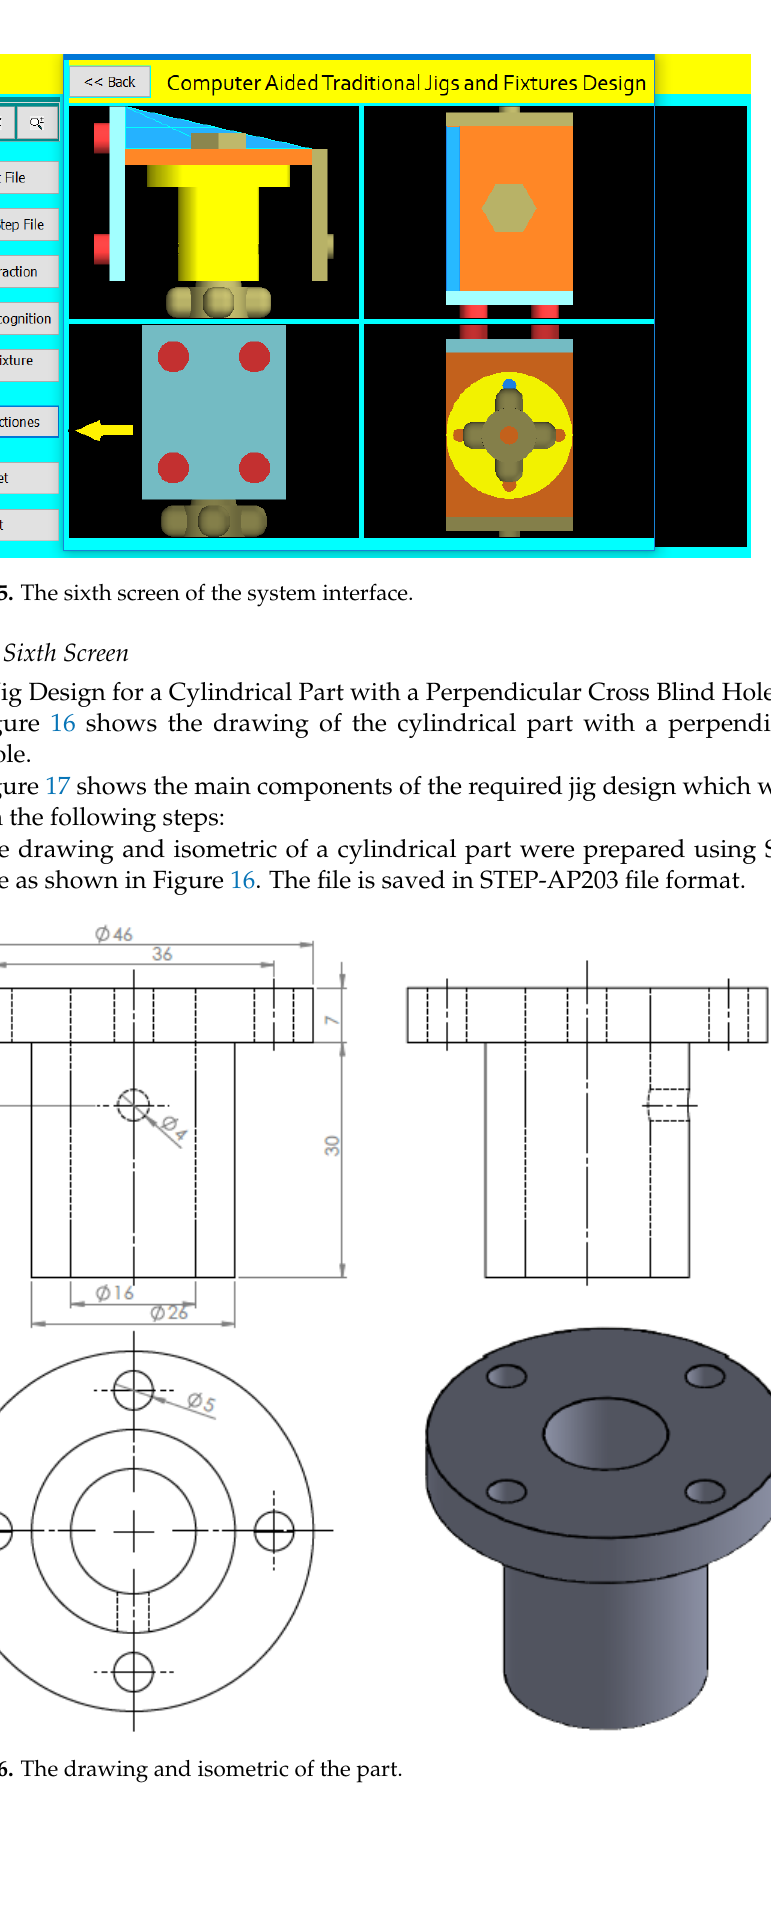
Figure 14. The fifth screen of the system interface.